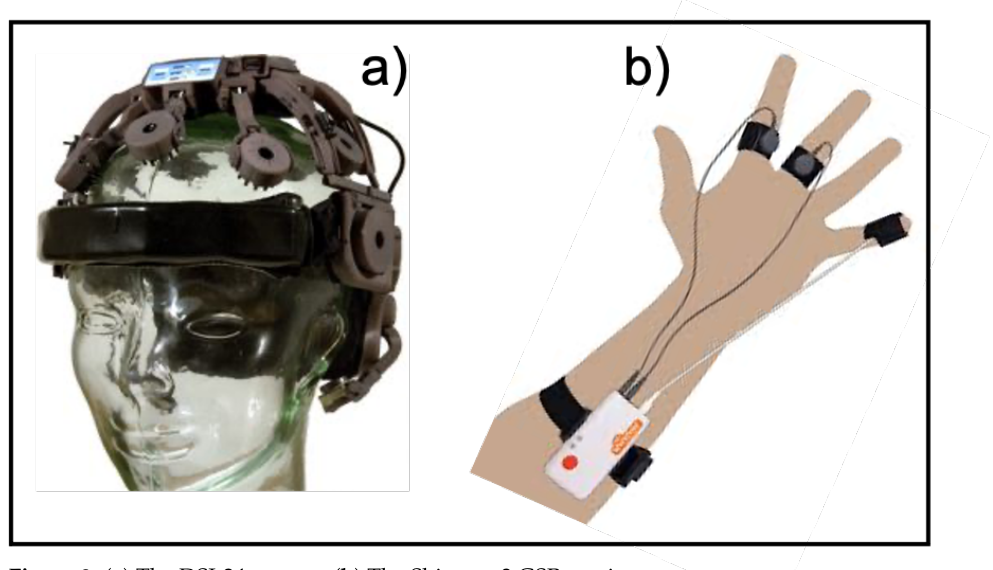
Figure 3. ( a ) The DSI-24 system. ( b ) The Shimmer3 GSR+ unit.